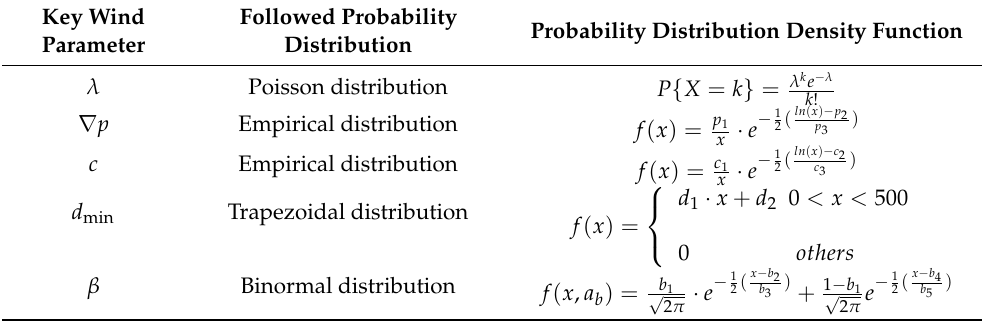
Table 1. Function fitting of typhoon key parameters